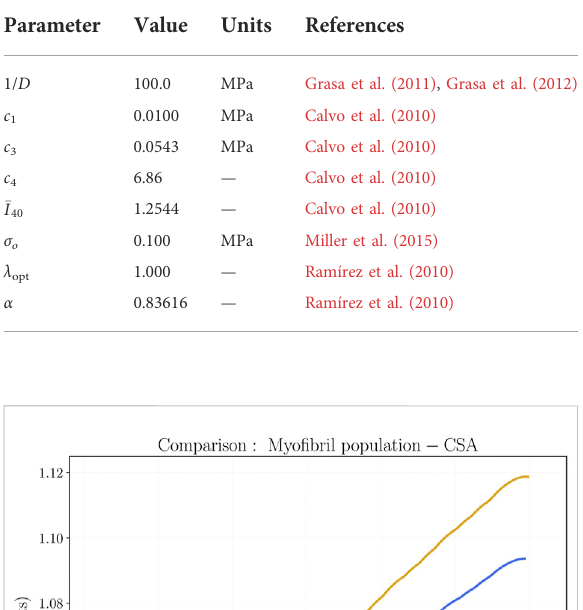
TABLE 2 Parameters for the mechanical model.